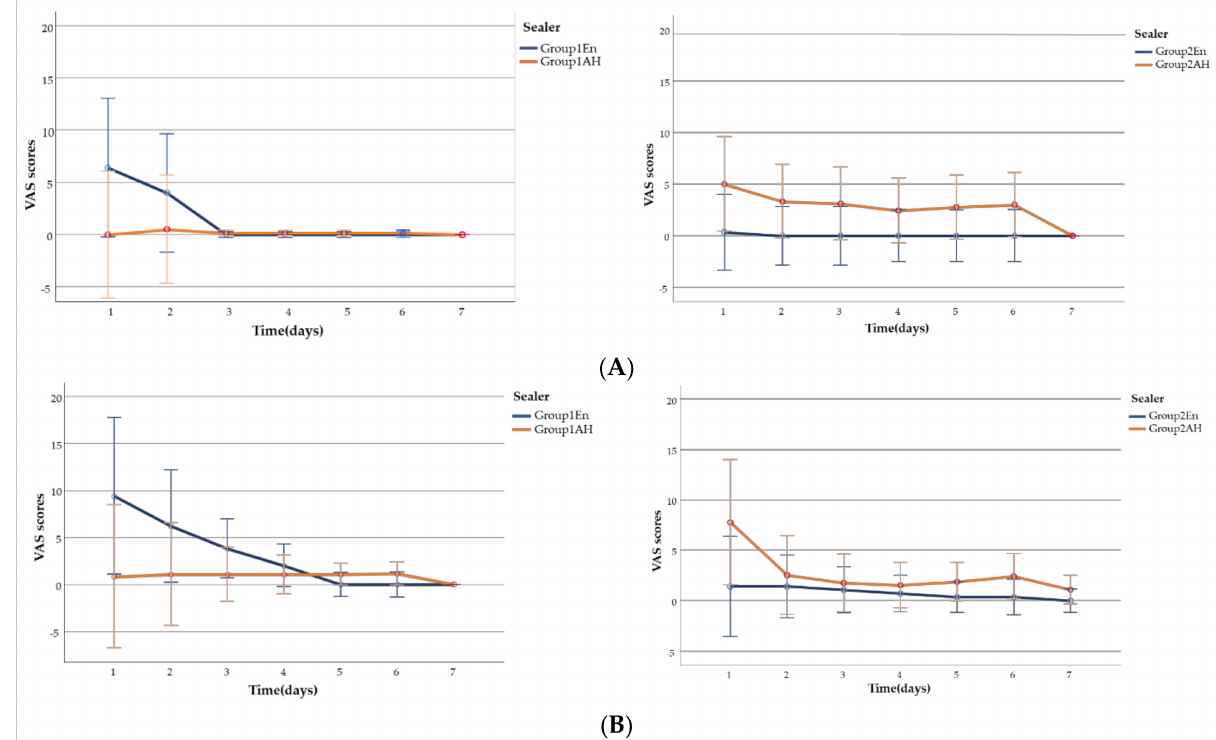
Figure 2. ( A ) Intensity of postoperative pain at rest over a 7 day period. The values are estimated means. The bar represents the 95% confidence interval. Repeated-measures ANOVA was used for the analysis. ( B ) Intensity of pain while biting over the 7 day postoperative period. The values are estimated means. The bar represents the 95% confidence interval. Repeated-measures ANOVA was used for the analysis.